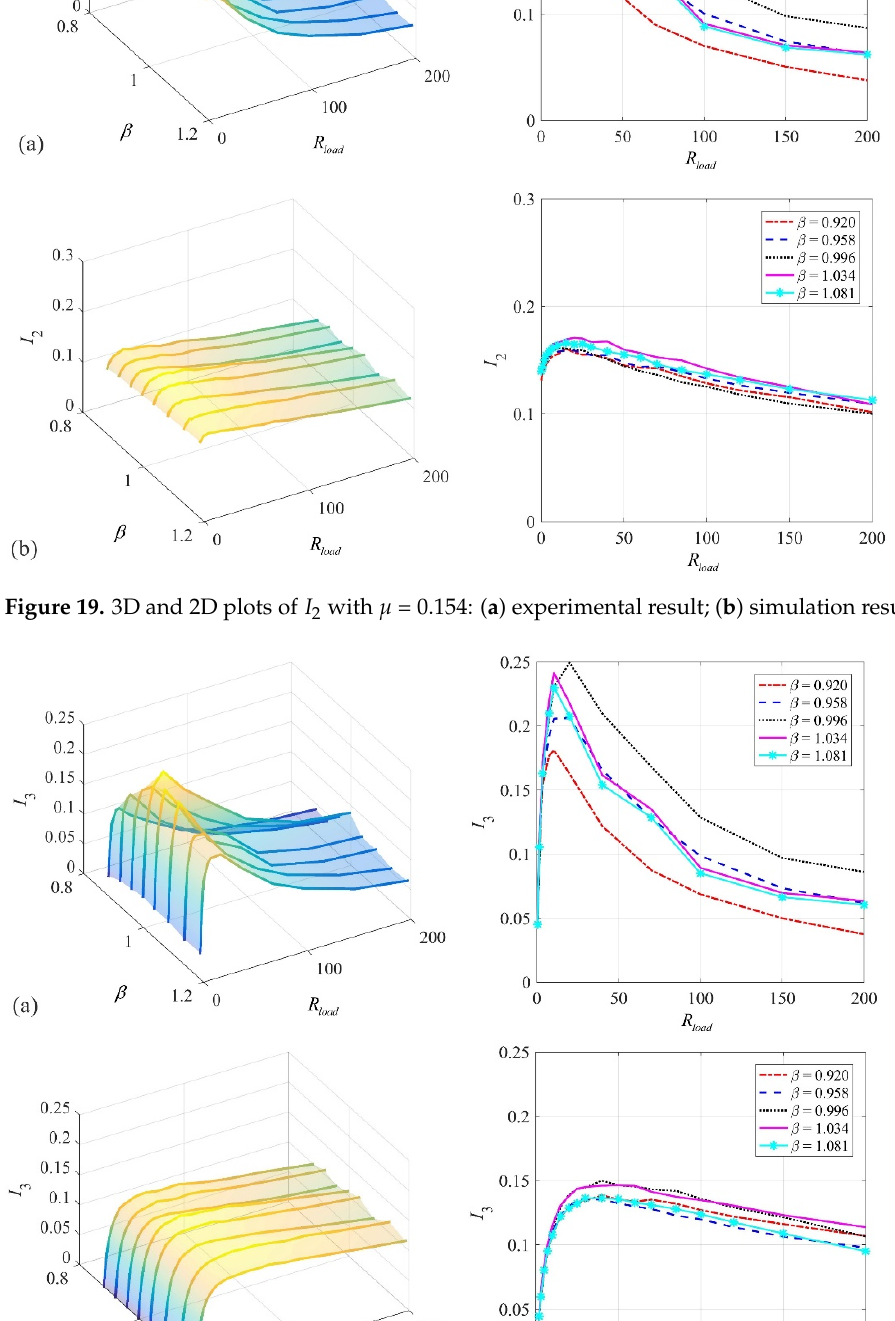
Figure 20. 3D and 2D plots of I 3 with µ = 0.154: ( a ) experimental result; ( b ) simulation result.